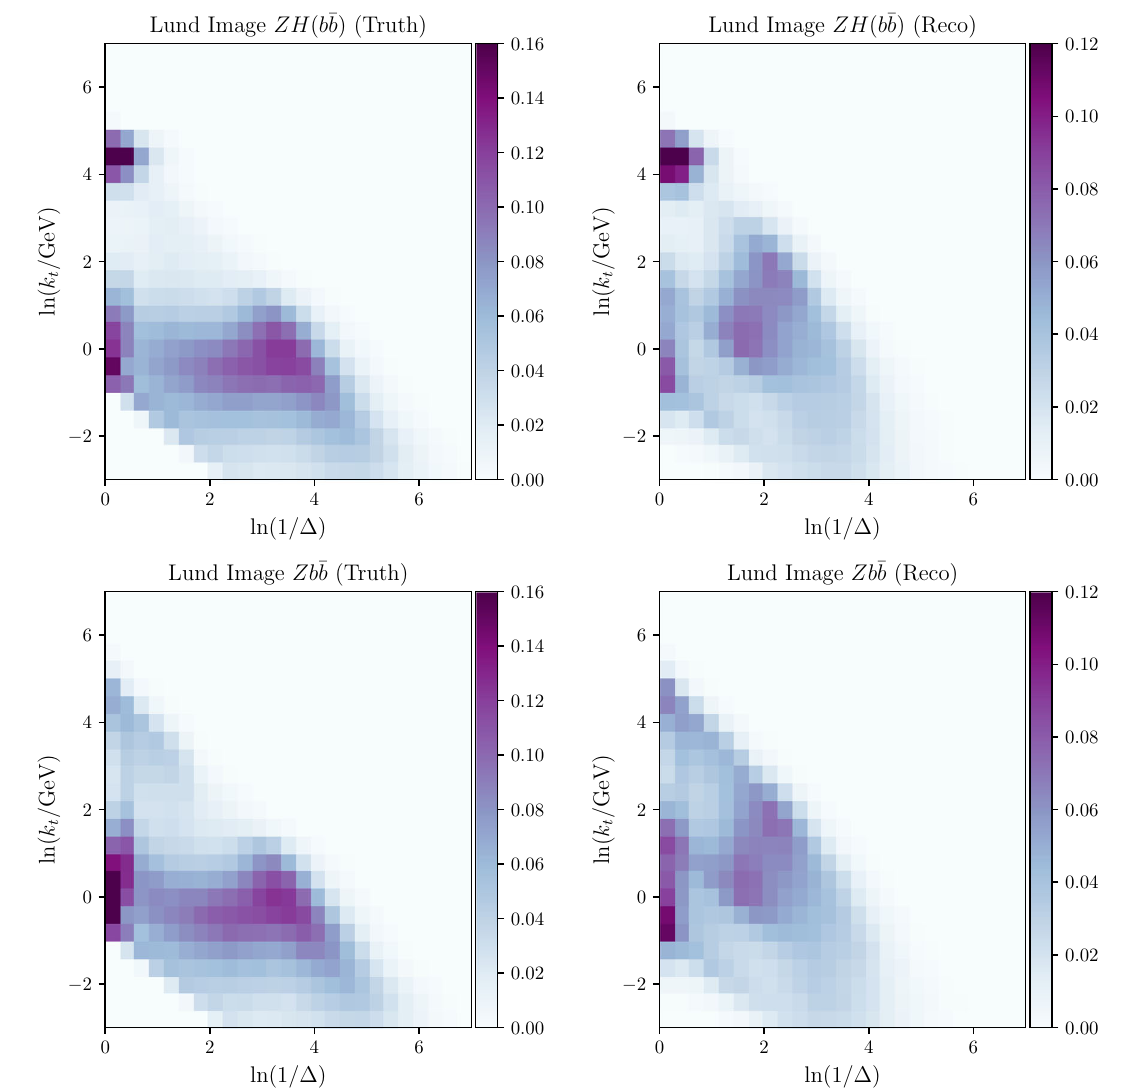
Fig. 3 Averaged primary Lund jet plane images for Z H ( b ¯ b ) and Zb ¯ b in the truth and reco case